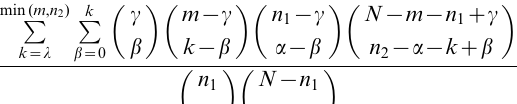
Figure S3 Performance of predicted motif - GO associations using cross-species comparison, evaluated based on genetics-based binding data.